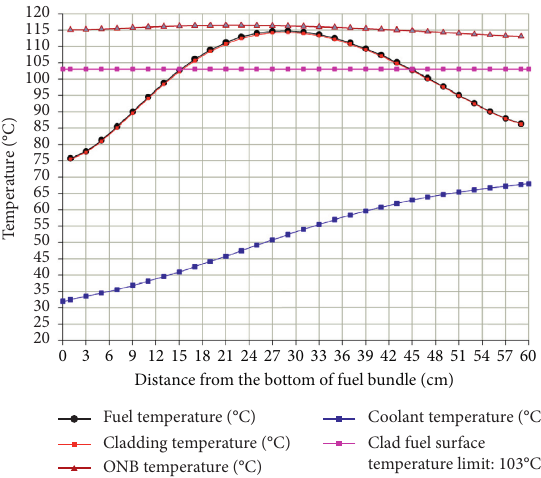
Figure 10: Calculated temperatures at nominal power with global and local hot channel factors (with systematic and random